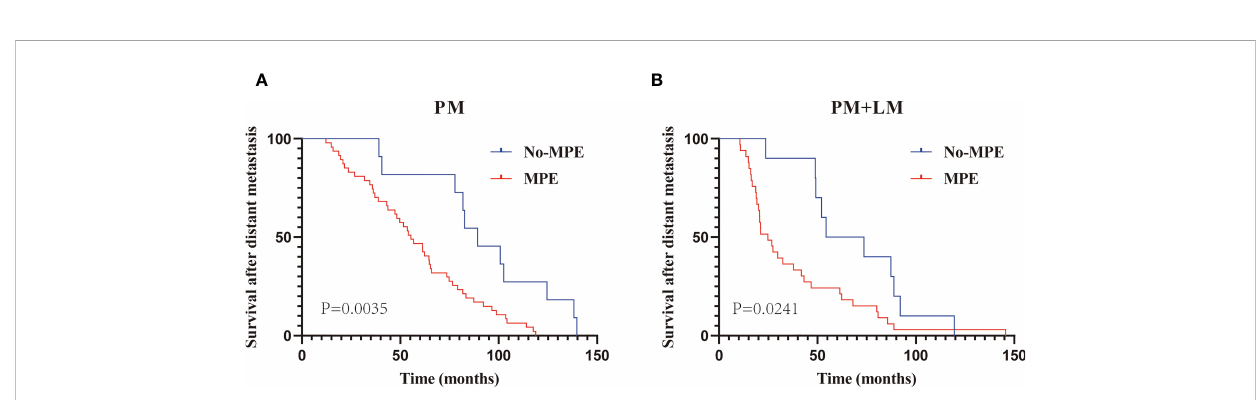
FIGURE 3 The Kaplan – Meier curve analysis of M-OS in PM with or without MPE. Patients with only PM (A) ; patients with PM and LM (B) . PM, Pleural metastasis; MPE, Malignant pleural effusion; LM, Lung